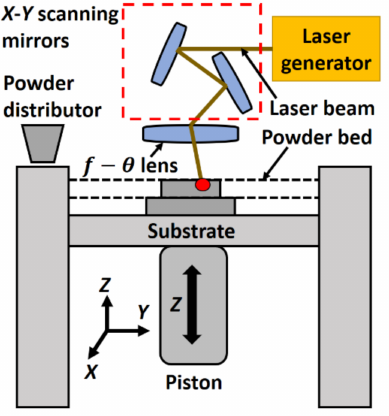
Figure 1. Schematic diagram of selective laser sintering and